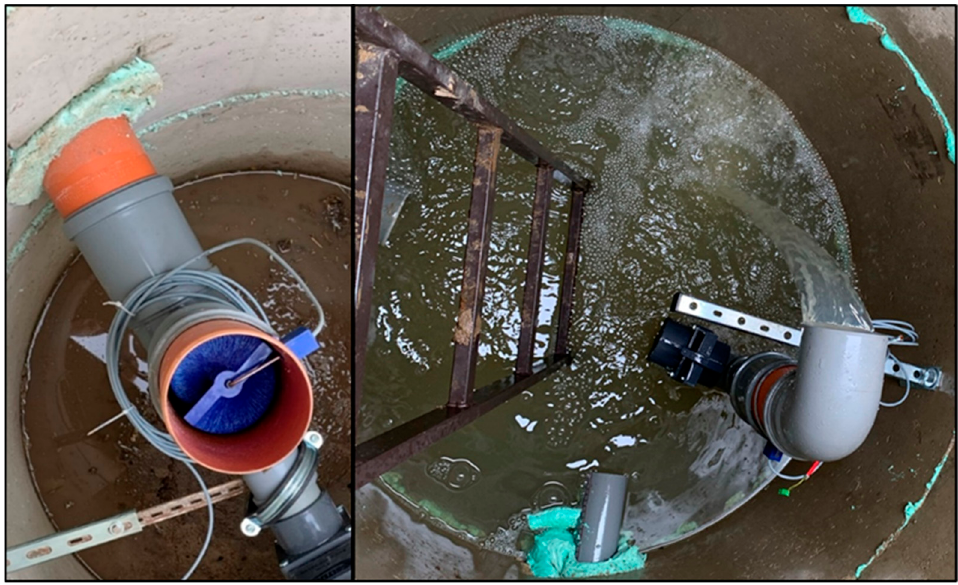
Figure 3. Fixed WLCS installed in the manhole with propeller flow meter (left) and water overflow after a rainfall-runoff event on May 14, 2021.